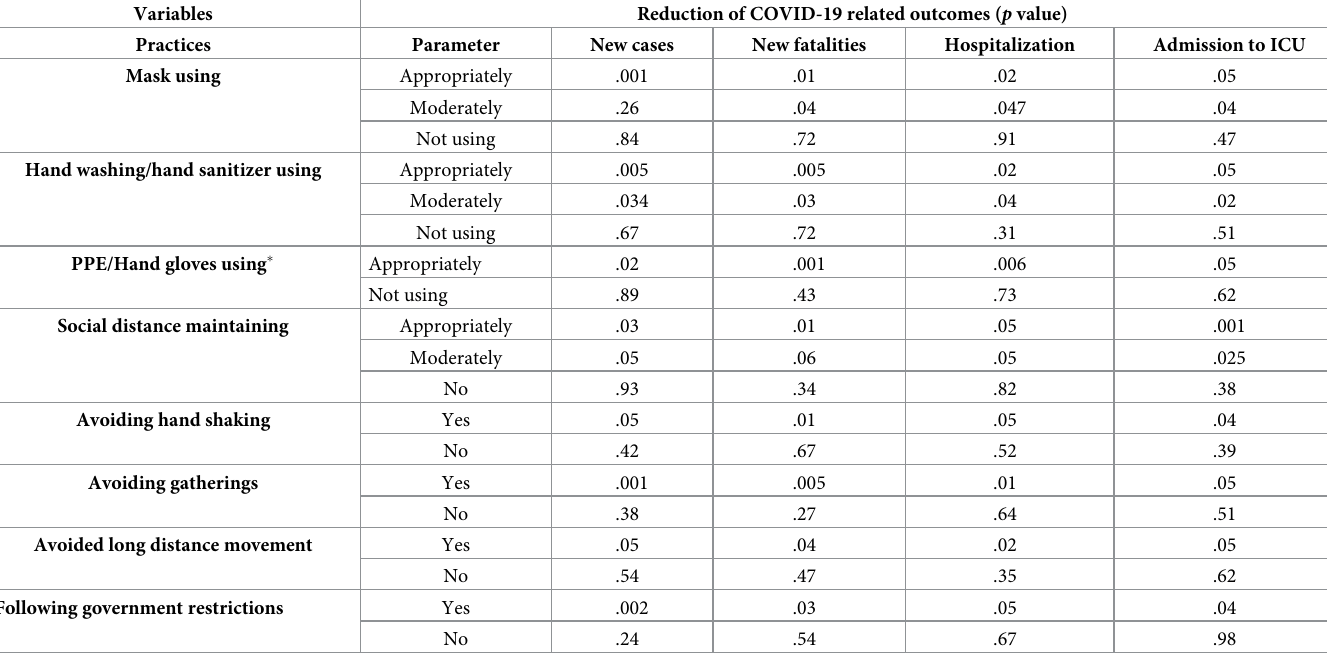
Table 3. Measures of association among the preventive measures and COVID-19 related health